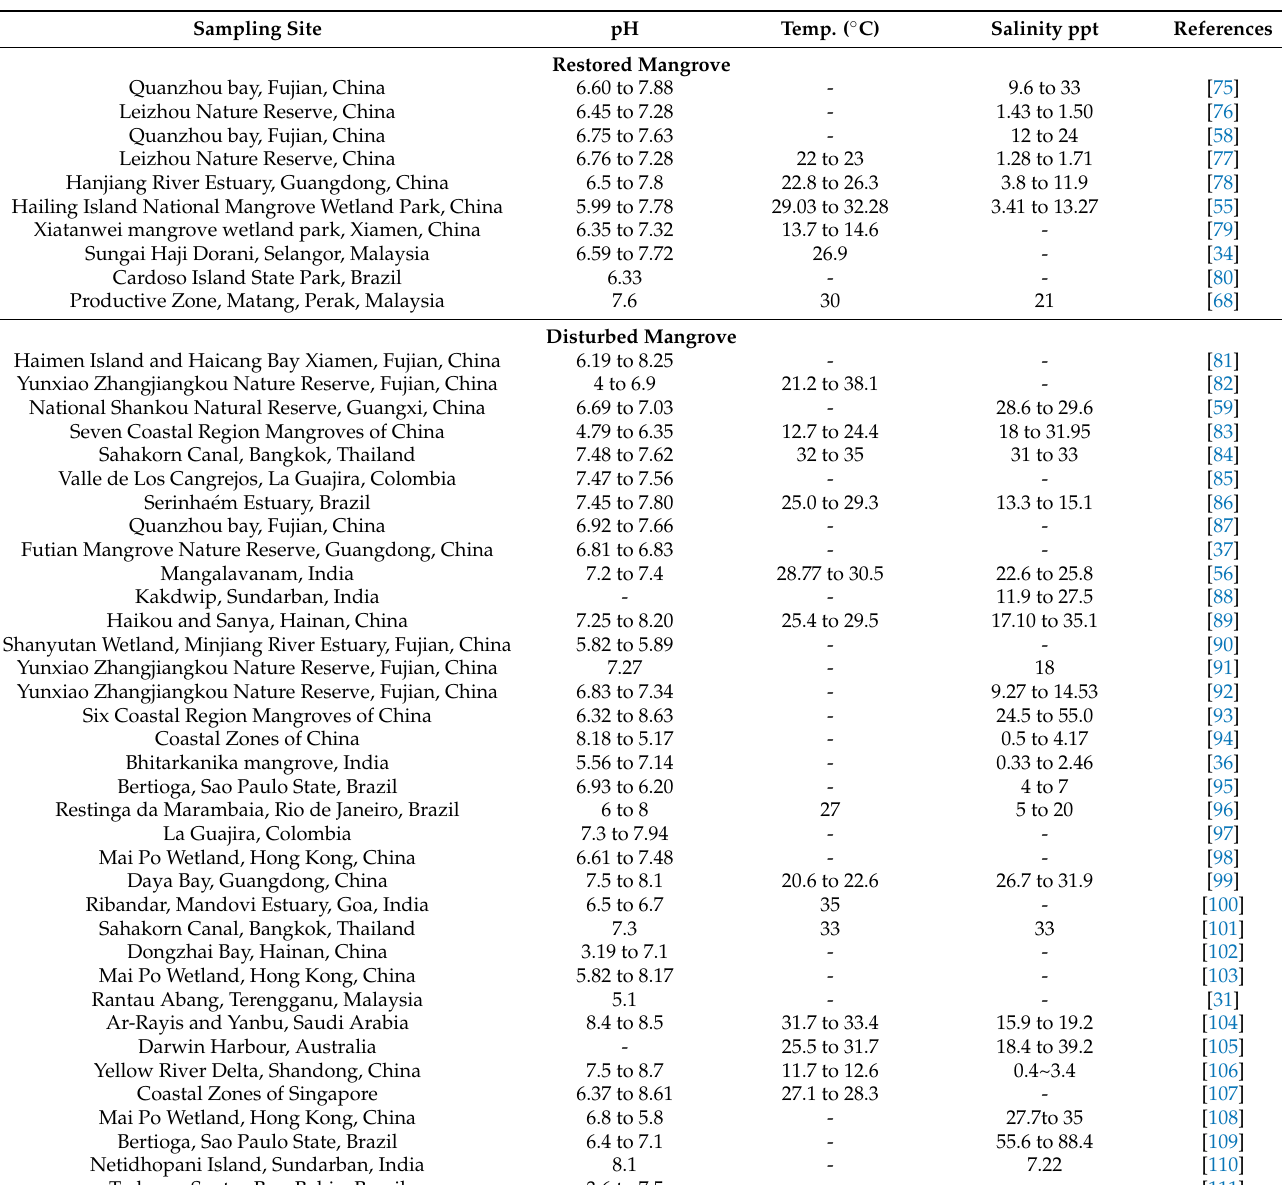
Table 2. Cont. Sampling